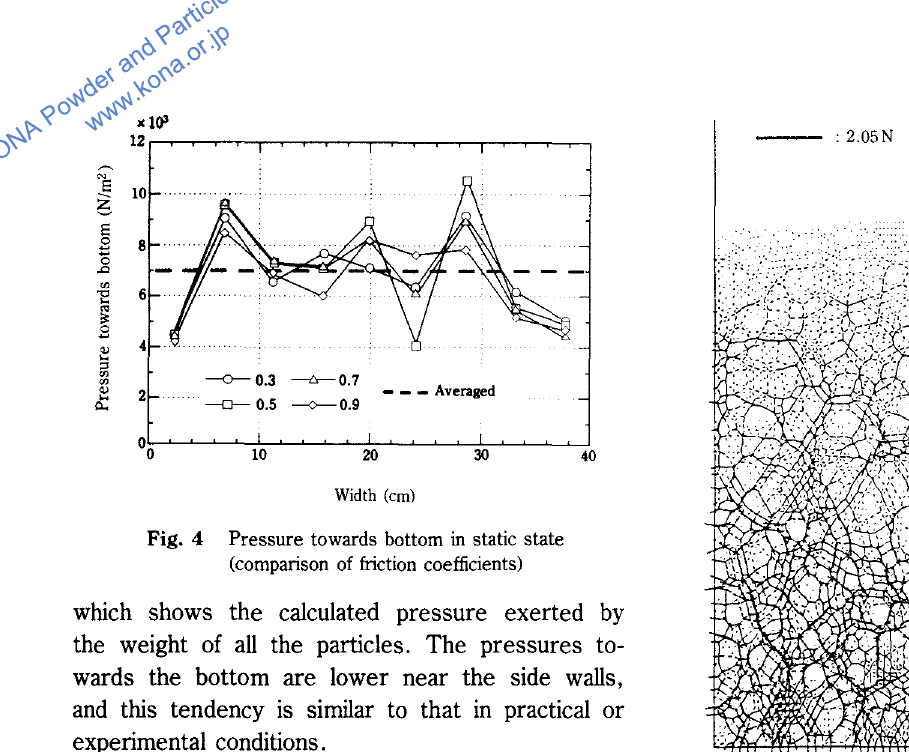
Fig. 5 Distribution of contact forces (friction coefficient p. ;